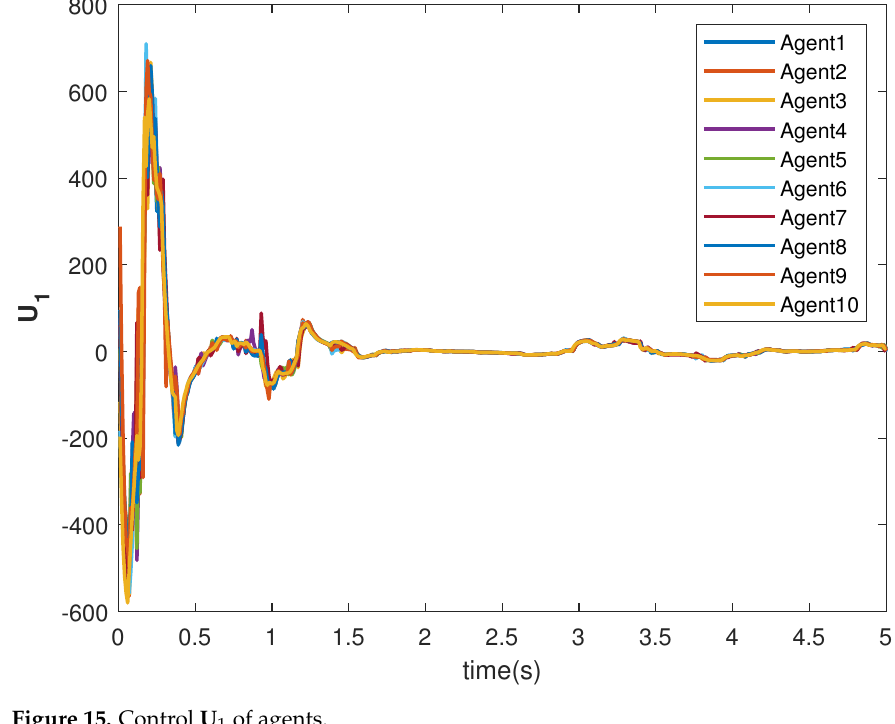
Figure 15. Control U 1 of agents.